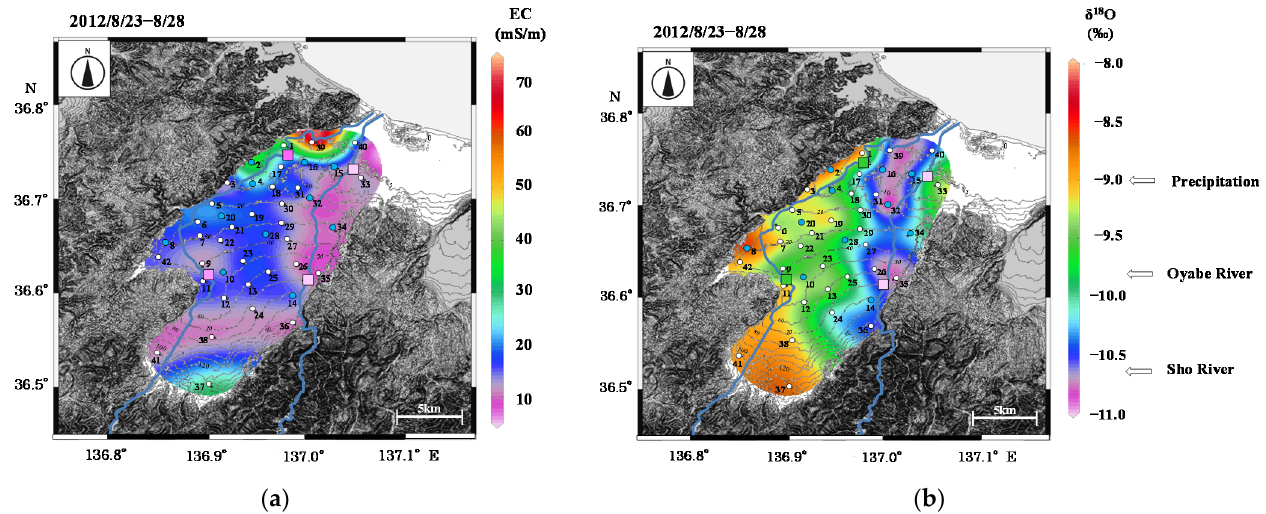
Figure 7. Contour maps of ( a ) EC and ( b ) δ 18 O for groundwater samples in August 2012.